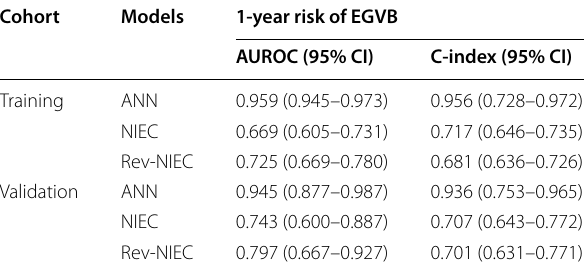
Abbreviations : ANN Artificial neural networks, AUROC Area under the receiver operating characteristic curves, CI Confidence interval, C-index Concordance index, EGVB Esophagogastric variceal bleeding, NIEC North Italian Endoscopic Club, Rev-NIEC Revised North Italian Endoscopic